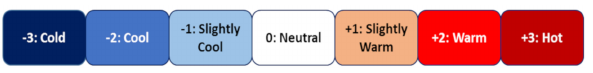
Figure 5. Predicted mean vote